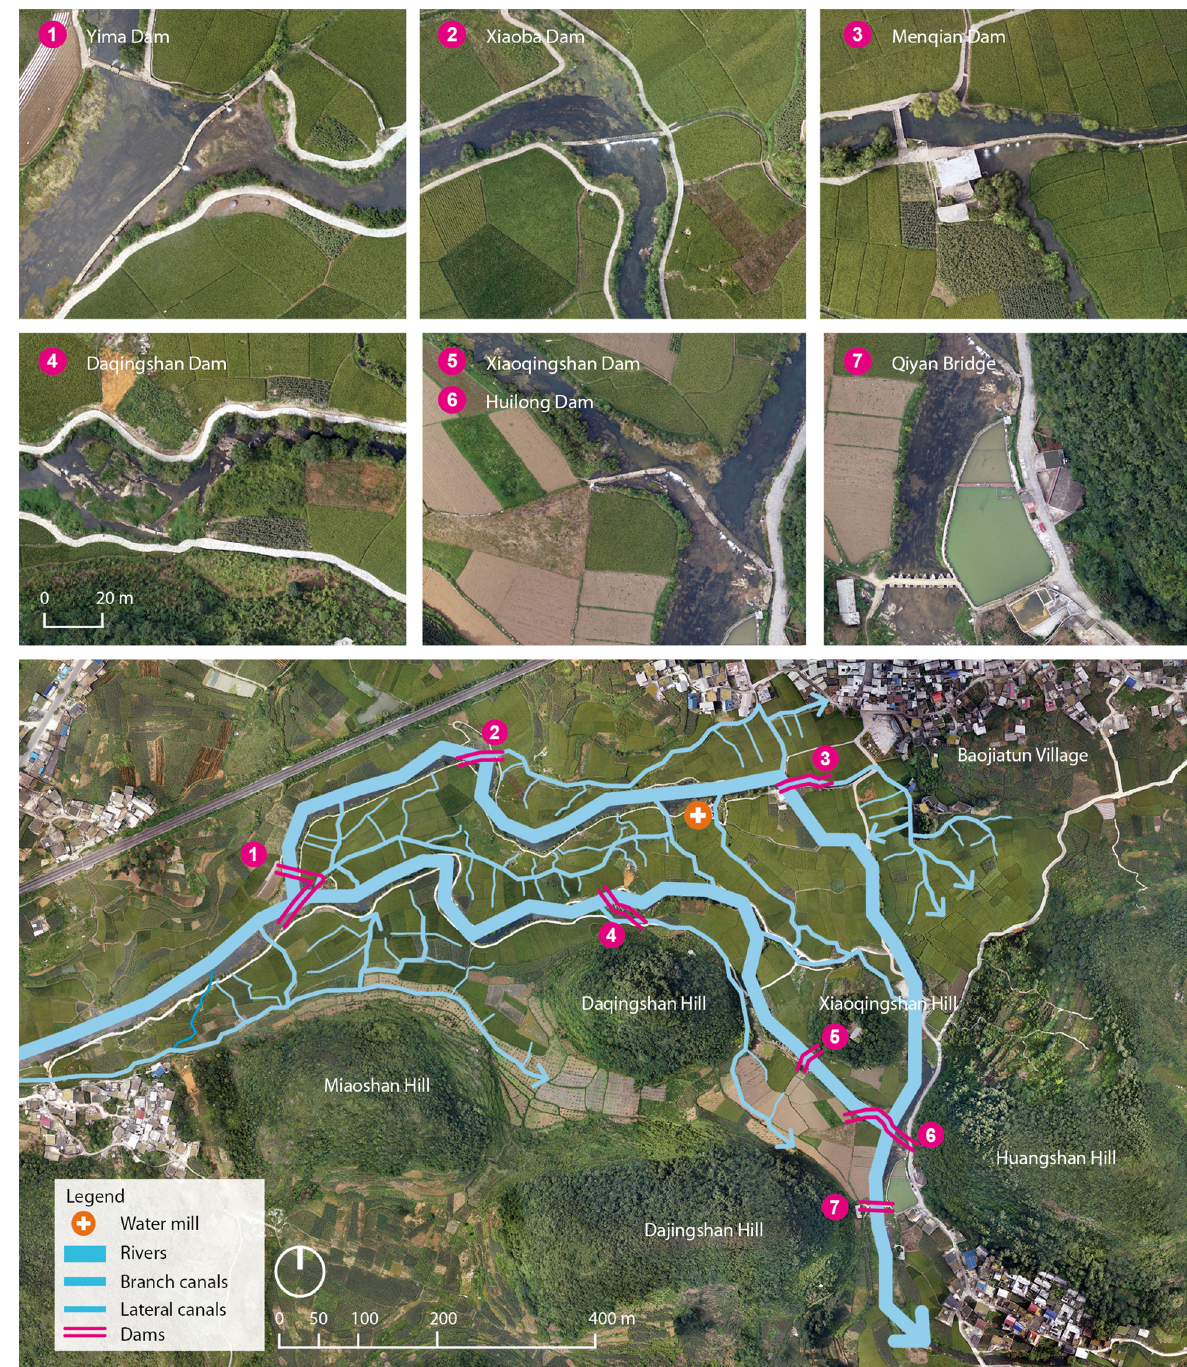
Fig. 6 Current condition of water management system and facilities recognised using digital high-precision orthophotos (Source: the